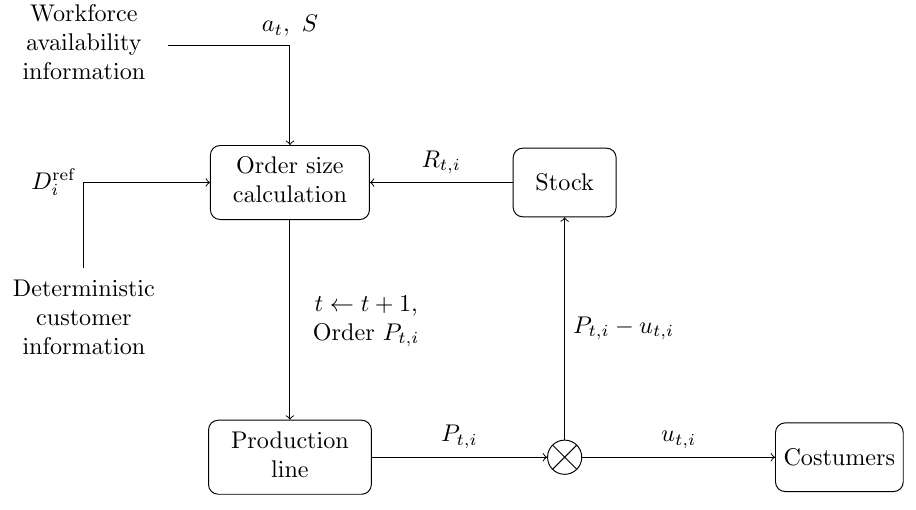
Figure 3. Inventory control